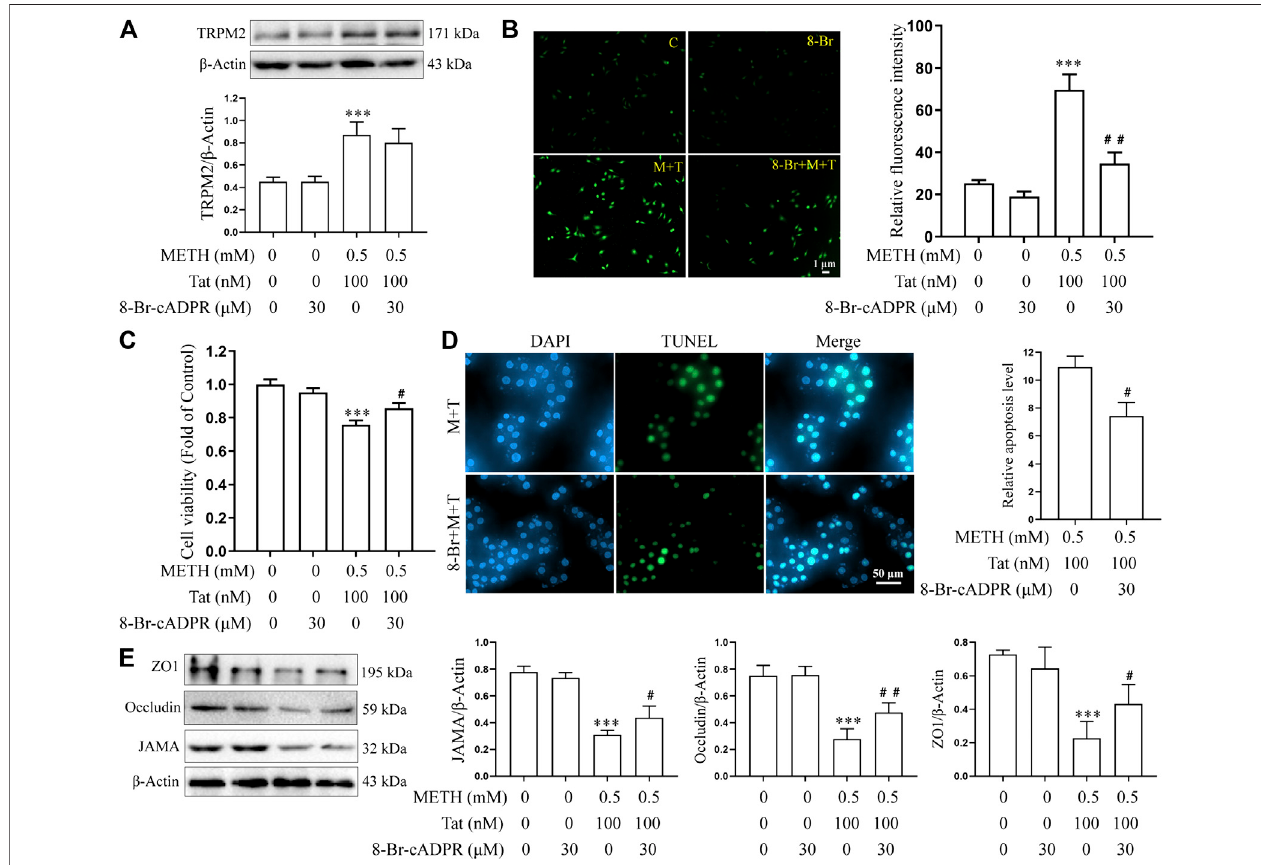
FIGURE 5 | 8-Br-cADPR attenuates damage to the BBB induced synergistically by METH and HIV-Tat in vitro . The hCMEC/D3 cells were treated with or without 30 μ Mof 8-Br-cADPRfor 0.5 h before 0.5 mM ofMETH and 100 nM ofHIV-Tat for 24 h. (A) Western blot was performed todetermine the TRPM2 expression level; (B) the Ca 2+ fl uorescence was observed via an inverted fl uorescence microscope (Scale bar: 1 µm); fl uorescence intensity was analyzed using Image J software; (C) cell viability was measured using the CCK8 kit; (D) apoptosis was assessed via TUNEL assay (Scale bar: 50 µm), apoptosis level was determined by the number of TUNEL-positive cells expressed as a percentage of the total cell number (analyzed by Image J software); (E) western blot was performed to determine JAMA, Occludin, andZO1expressionlevels.Compared withthecontrol,*** p < 0.001;comparedwiththeMETH+HIV-Tat, # p < 0.05, ## p < 0.01,n (cid:1) 3.C (cid:1) Control,8-Br (cid:1) 30 μ Mof8-Br- cADPR, M + T (cid:1) 0.5 mM ofMETH+100 nM ofHIV-Tat, and 8-Br +M + T (cid:1) 30 μ M of8-Br-cADPR+0.5 mM of METH+100 nM ofHIV-Tat. The Ca 2+ fl uorescence shown in (B) was detected after the cells were treated with or without 30 μ M of 8-Br-cADPR for 0.5 h before 0.5 mM of METH and 100 nM of HIV-Tat for 0.5